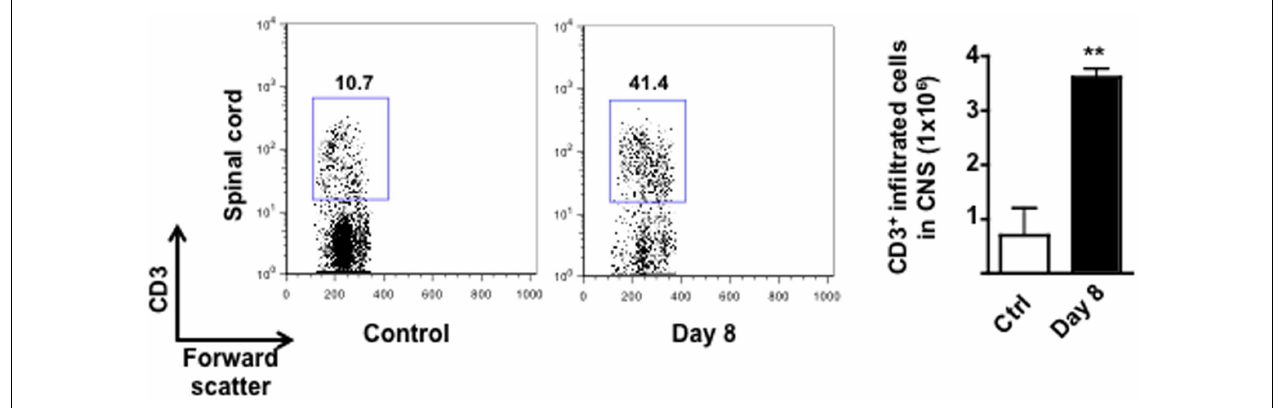
MOG 33–55 -immunized mice.Values are expressed as mean ± SEM for three mice and are representative of N = 3 separate experiments. ** p < 0.01 indicates significant values compared to control